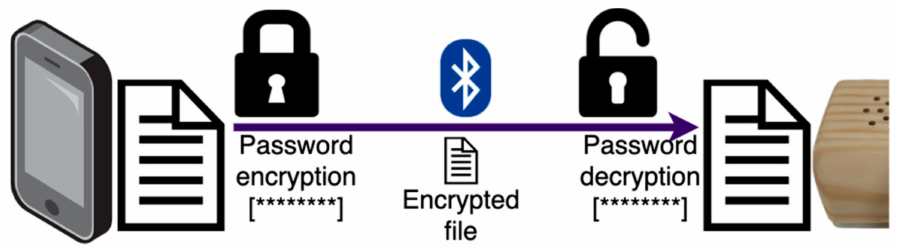
Figure 7. Synchronisation process following symmetric